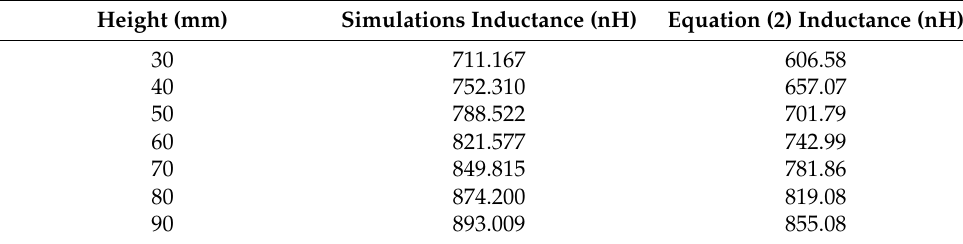
Table 12. Inductance calculation of a single loop rectangle with a constant width (260 mm) using Ansys simulations and Equation